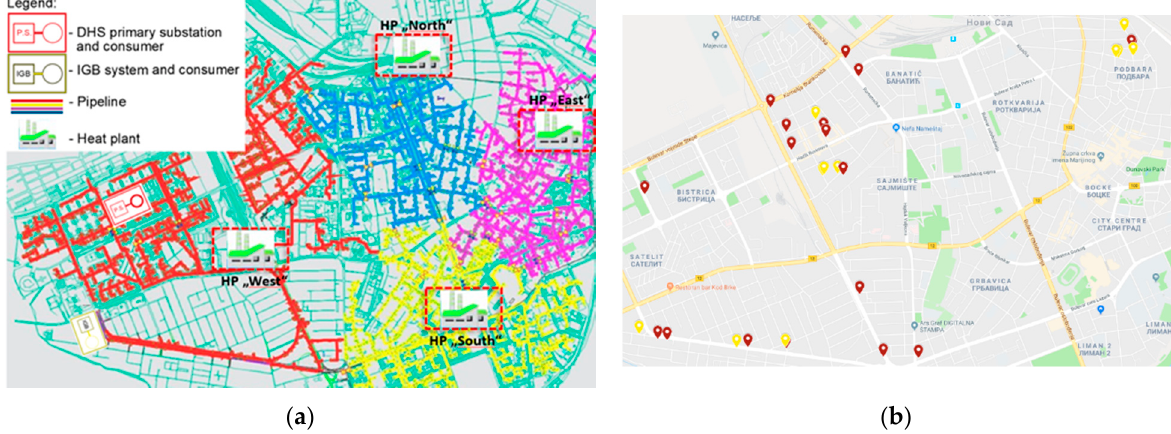
Figure 5. Schematic diagram of applied heating system ( a ) and locations of analyzed buildings (DHS—red pointers; IGB—yellow pointers) ( b ).